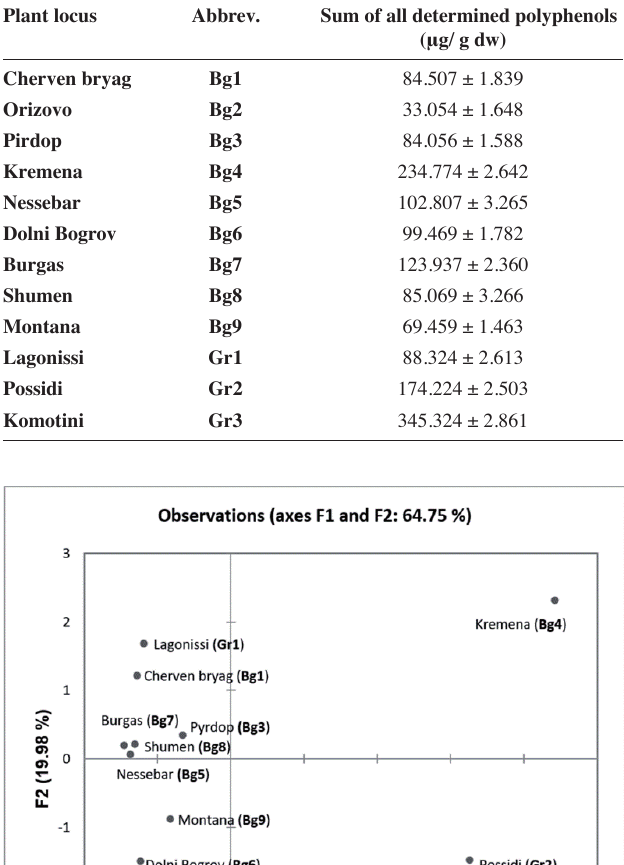
Tab. 7: Total antioxidant compounds in the different batches. Plant locus